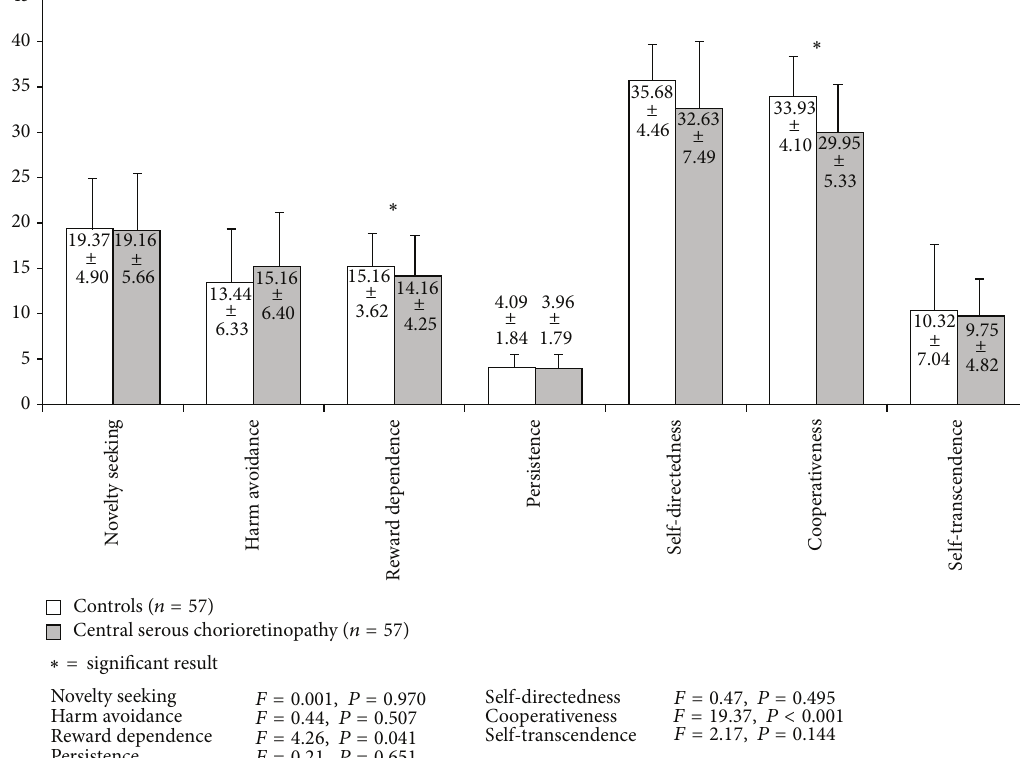
Figure 2: On the Temperament and Character Inventory (TCI) CSC patients scored significantly lower on the scales cooperativeness ( 𝐹(1,111) = 19.374 , 𝑃 < 0.001 ) and reward dependence ( 𝐹(1,111) = 4.263 , 𝑃 < 0.041 ) in contrast to